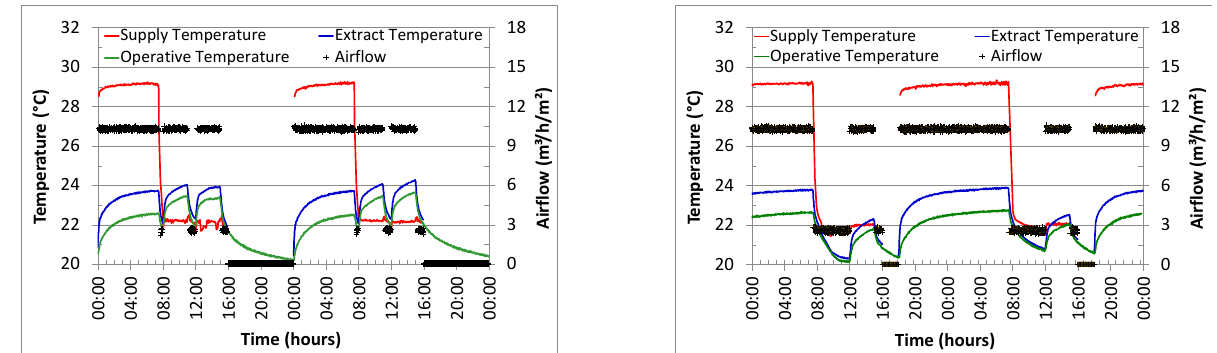
Figure 12. Measured supply, extract, and operative temperatures, and airflows for Scenario I ( left ) and Scenario II ( right ) of the lab test.